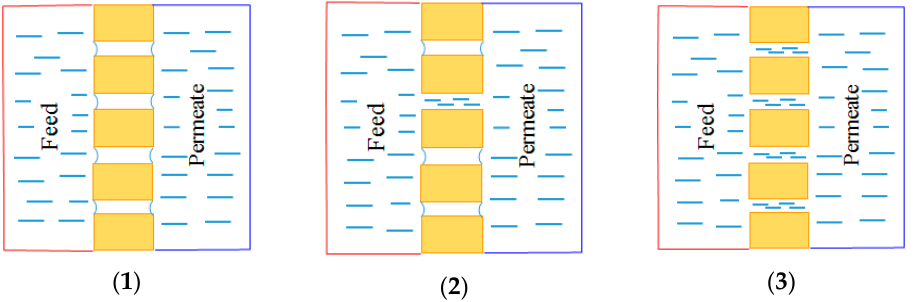
Figure 1. Mechanism of membrane wetting: ( 1 ) surface wetting, ( 2 ) partial wetting, ( 3 ) fully wetting. Wetting phenomenon can be classified into three types: surface wetting, partial wetting and fully wetting. When only the membrane surface is wetted, the membrane does not lose its separation function; when partial membrane pores are wetted, the membrane starts to lose its separation ability and the conductivity of the permeate increases gradually. When all the membrane pores are wetted, the membrane loses its separation ability completely. At the same time, considering the existence of different pollutants (micro particles, acid, base, oil, etc.) in the feed solution, this will lead to the deposition of pollutants on the membrane surface or in the membrane pores, and also destroying the membrane surface structure and reducing the hydrophobicity of the membrane. This is typical membrane fouling. The latter is another undesired phenomenon that can severely degrade membrane performance and negatively impact the membranes during long-term operation. Even if it has been studied and investigated by researchers for many years, its mechanism is not well understood yet [14–16]. In general, membrane fouling can be divided into organic fouling, inorganic fouling and biological fouling based on the classification of foulant types. Inorganic fouling, or scaling, includes alkaline scaling, non-alkaline scaling and uncharged molecule scaling. The most common alkaline scaling is CaCO 3 . It can be formed from different feeds such as seawater, groundwater or brackish water disposal. It can also be generated from the breakdown of bicarbonate. It is reported that a temperature of 37 °C can be considered as the minimum temperature for the formation of CaCO 3 from the mildly concentrated ocean water. Other inorganic scales or colloidal fouling are Mg(OH) 2 , CaSO 4 , CaSO 4 •H 2 O, CaPO 4 , MgCl 2 , silica, Fe 2 O 3 , Fe(OH) 3 , Fe 3 O 4 , FeO, etc. Organic fouling is defined as the collection of carbon-based material on a membrane. Biofouling, normally occurs through food, beverage, and industrial wastewater as feed, of which their COD are very high. It includes bacteria, fungi, etc. Fouling images on the membrane surface in MD are shown in the following Figure 2.